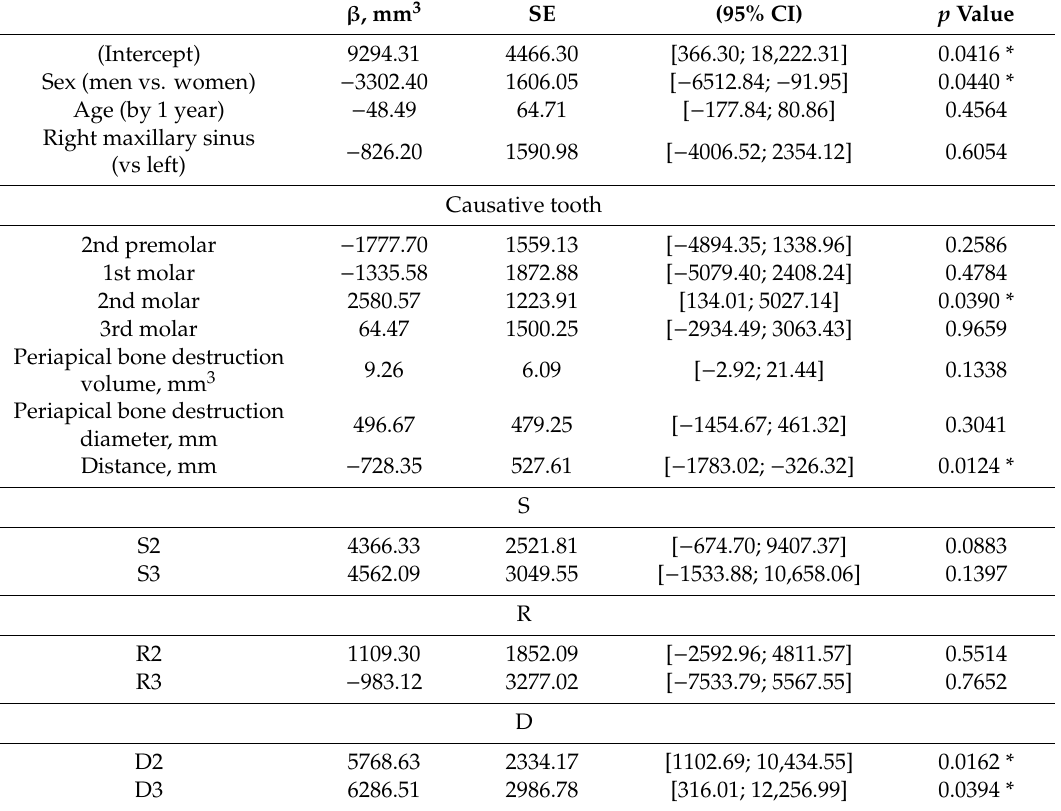
Figure 5. Clinical case I—mucosal thickening—advanced, periapical bone destruction size S3; Clinical case II—mucosal thickening up to 2 mm, periapical bone destruction size S3. Computed tomography axial ( A ), coronal ( B ) and sagittal ( C ) views of apical periodontitis around the roots of the teeth and maxillary sinus mucosa thickening. The lesions are indicated with black arrows. Table 4. Univariate multiple regression analysis model to determine risk factors of maxillary sinus mucosa thickening volume in mm 3